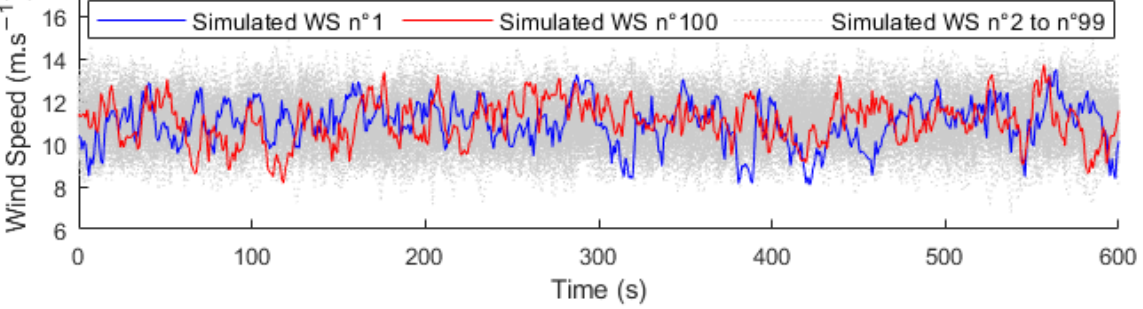
Figure 7. Simulation of 100 stochastic wind speed signals with V = 11 m · s − 1 and TI = 10% for a period of 10 min.